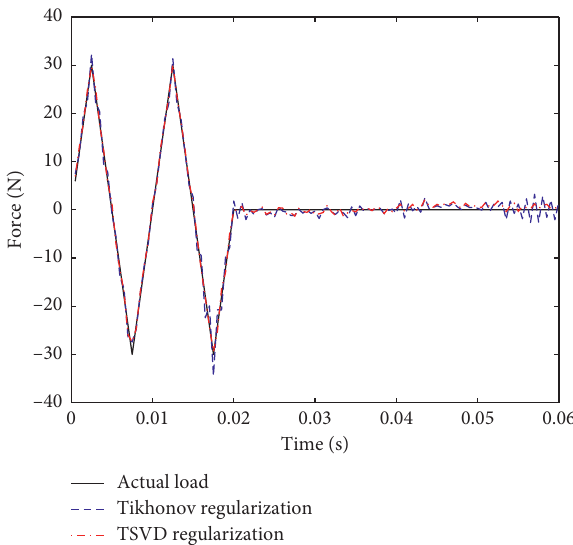
Figure 7: Identification results of triangular loads under 5% noise.